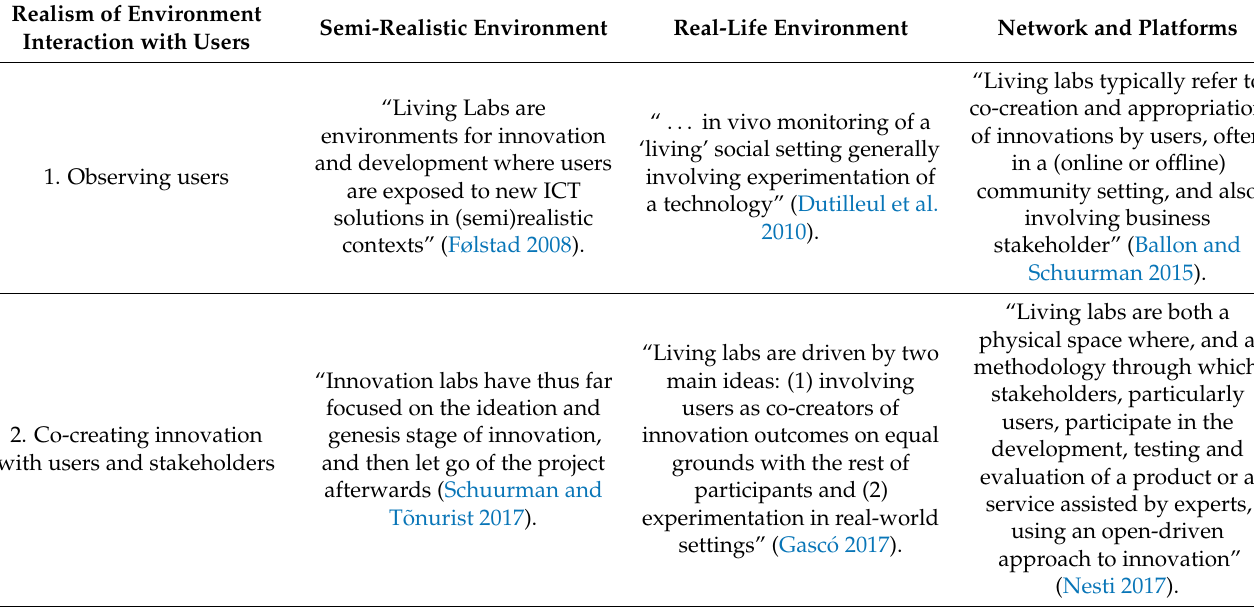
Table 1. Types of living lab environments—examples from the